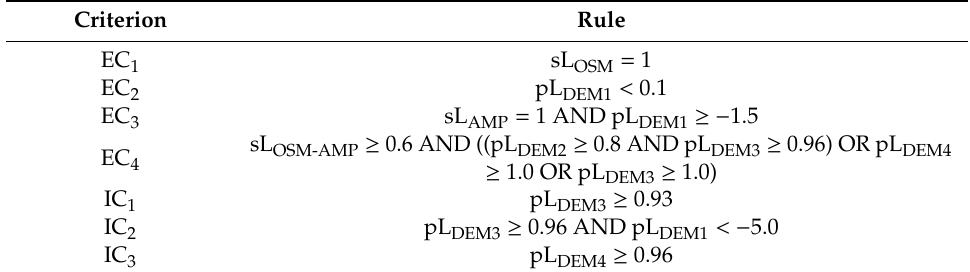
Table 1. Rules to identify ground points based on a set of exclusion (EC) and inclusion criteria